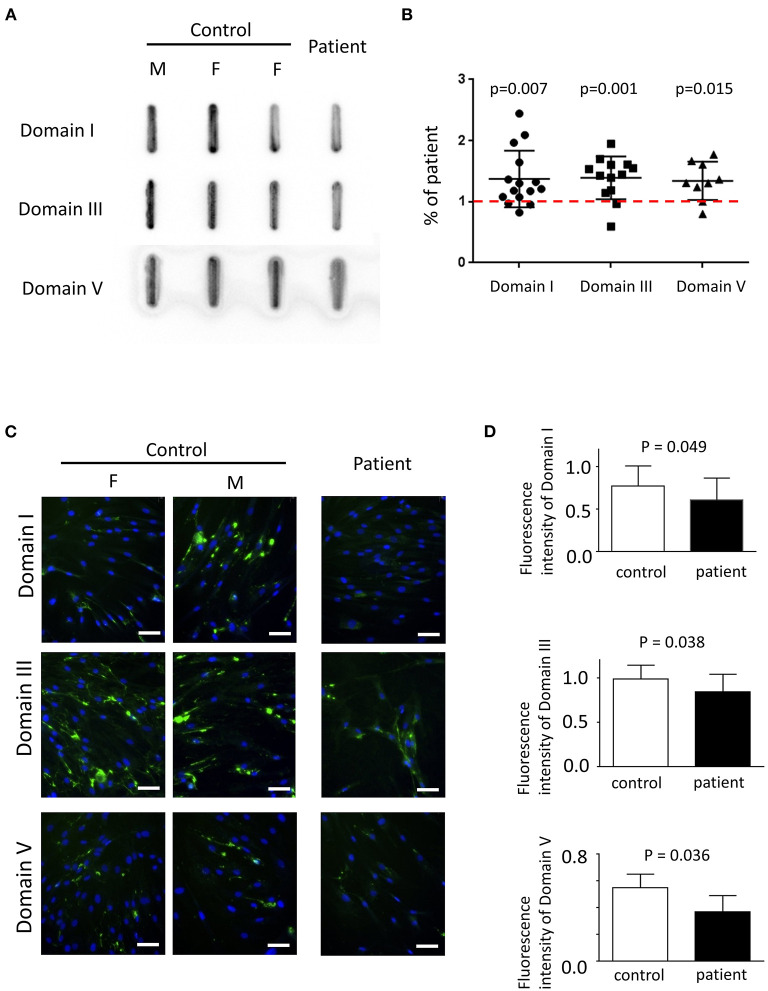
The expression of perlecan in primary fibroblasts. (A) Quantitative dot blotting of fibroblast conditioned medium from one patient and three normal subjects (one male and two female subjects). Representative pictures from at least three independent experiments. (B) Quantified intensity of each band was normalized to the final cell counts. Dot intensity of all subjects was normalized to the patient. The ratio was compared to one, shown as a dashed red line (one-sample t-test). (C) Representative pictures of immunofluorescence from one patient and two normal subjects (one male and one female subjects) from six independent experiments (green, perlecan; blue, Hoechst; scale bar, 50 μm; F, female; M, male). (A,C) Perlecan was detected by antibody against domain I (top), domain III (middle), or domain V (bottom). (D) Comparisons of quantified expression levels of perlecan between control subjects and patients. Data, mean ± SD.